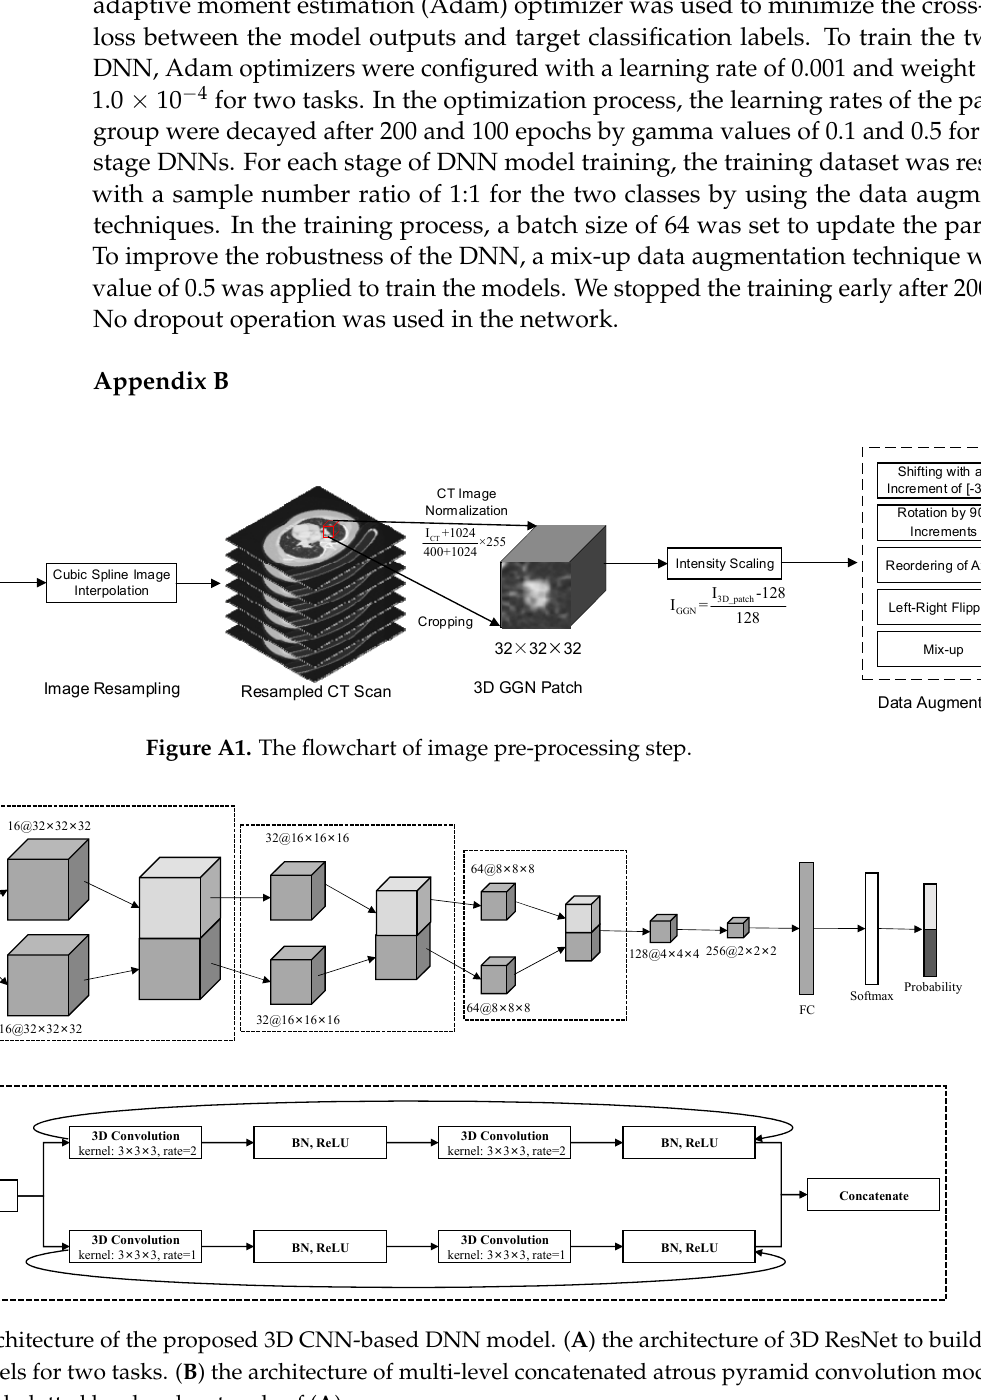
Figure A3. The training accuracy and loss curves for Task1 and Task2, respectively. The red dotted line marks the stopping point in the training process.